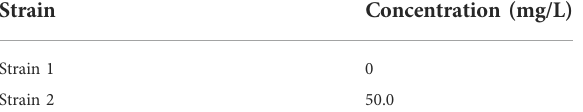
TABLE 2 The titer of 2-F-3-HP by whole-cell transformation.